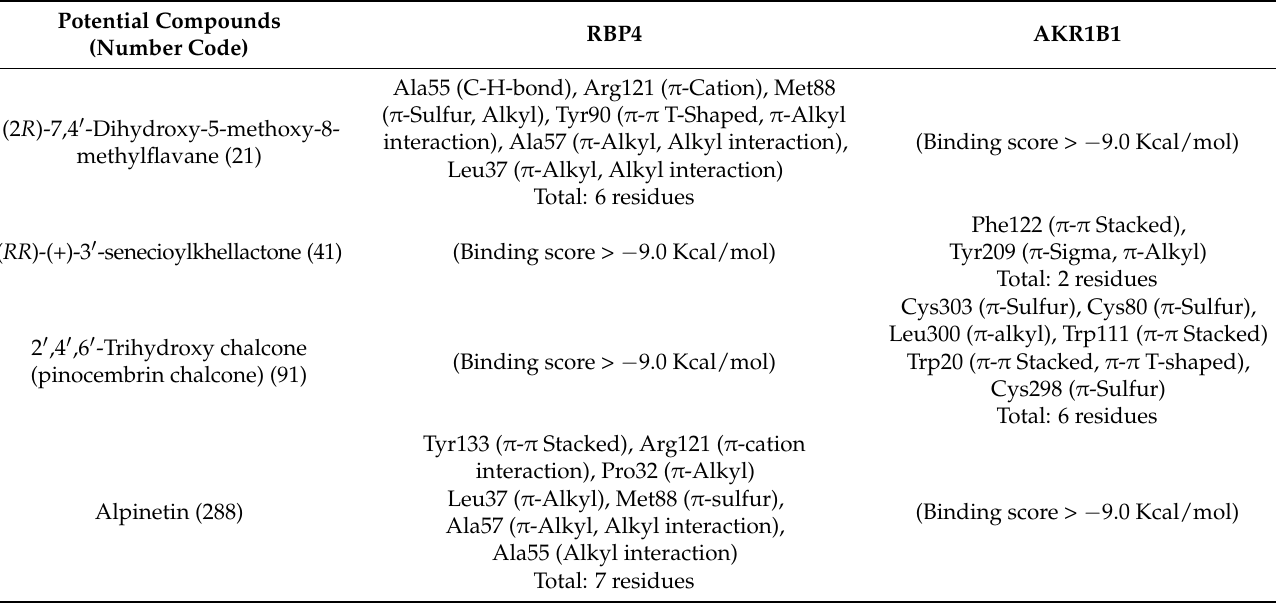
Table 8. Docking results of the interaction of 12 potentially active compounds of Asian propolis with favorable ADMET properties with protein targets related to